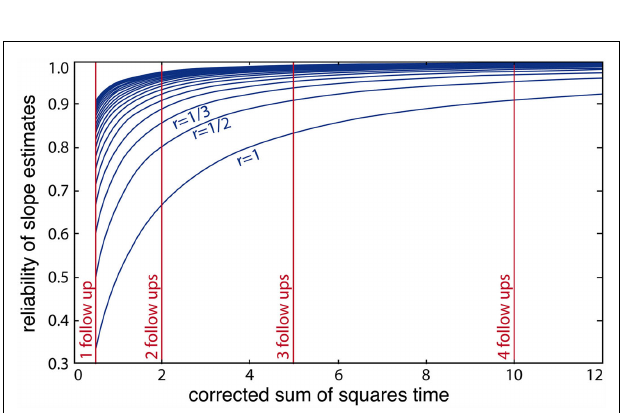
FIGURE 5 |Application of a linear decline model to a longitudinal sample of voxel-based morphometry data. The individual gray matter intercept and slope parameters were estimated using 572 MRI scans of 123 healthy subjects with ages 70–90 at baseline. Number of follow-ups varied from two